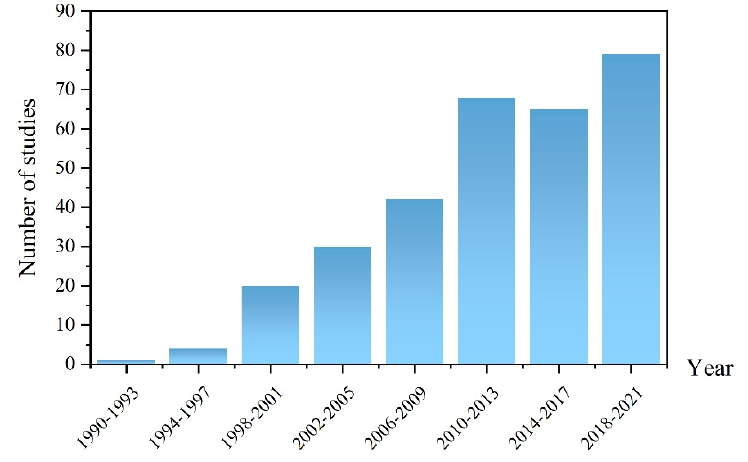
Figure 1. Number of studies published before Jan. 2021 that experimentally examined the position sensorless methods for SRM.